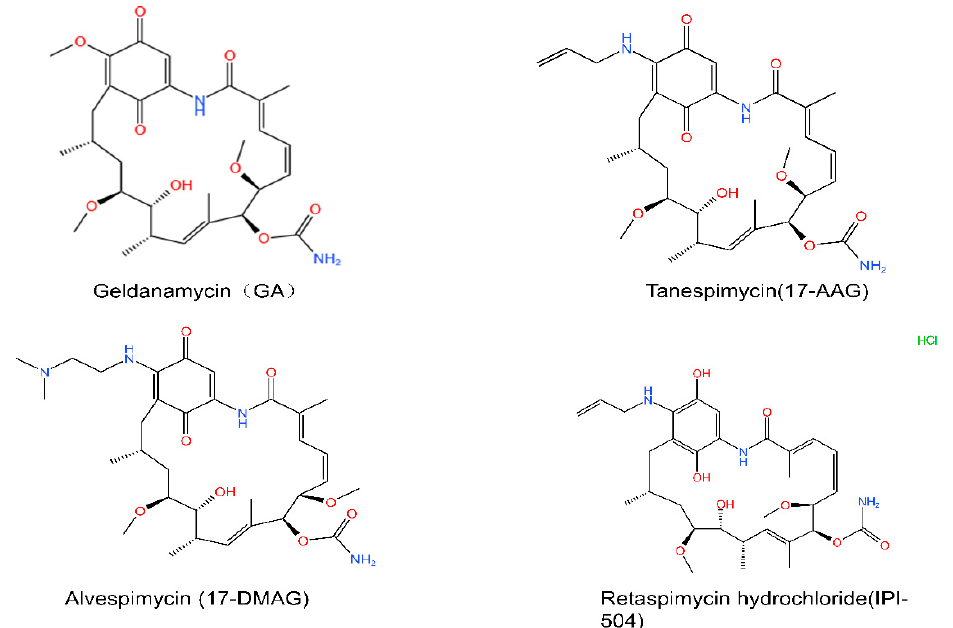
Figure 3. Chemical structures of GA-derived HSP90 inhibitors. GA and its derivatives 17-AAG, 17-DMAG and IPI-504. Chemical structures are from http://www.chemspider.com (Accessed on 16 August 2022).